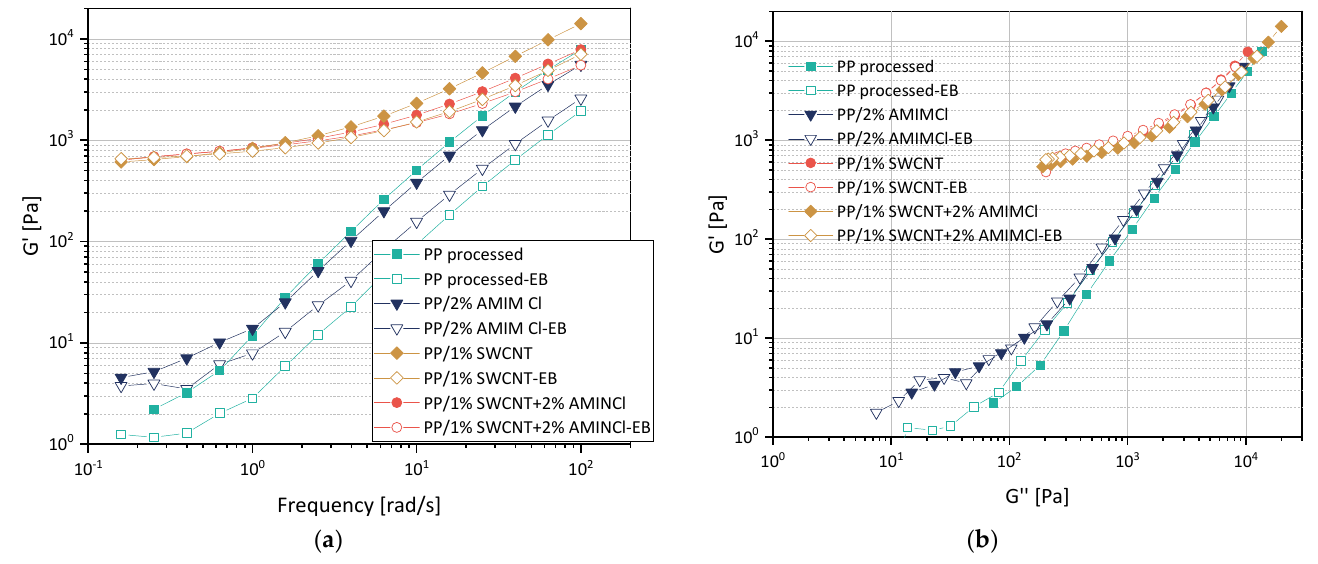
Figure 7. ( a ) Storage modulus G’ in dependence on frequency and ( b ) loss modulus G’’ at 210 °C of unfilled PP, PP/IL, PP/SWCNT and PP/SWCNT/IL composites before (filled symbols) and after (open symbols) electron beam irradiation (18 kGy).